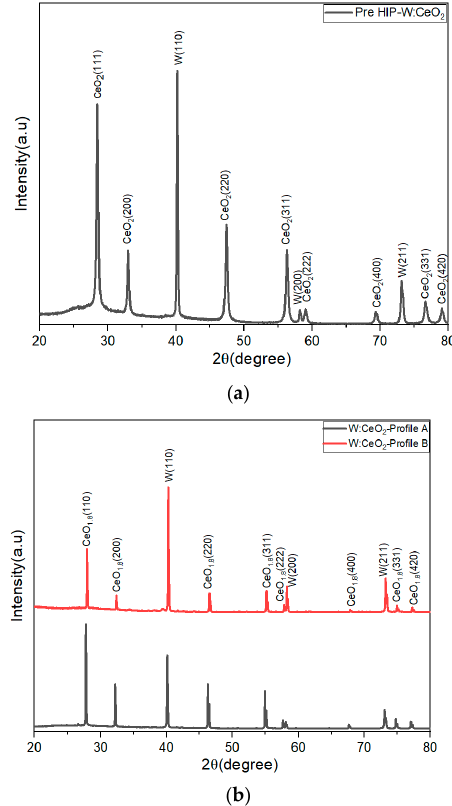
Figure 1. ( a ) PXRD analysis of 1:1 W-CeO 2 pre-HIP at temperature profile A and profile B conditions. ( b ) PXRD analysis of 1:1 W-CeO 2 composite and post-HIP at temperature under profile A and profile B conditions. The change from ( a ) to ( b ), shows the HIP process introduces a change in the Ce oxidation state, from only +4 before HIP to a combination of 4+/+3.6 post-HIP.